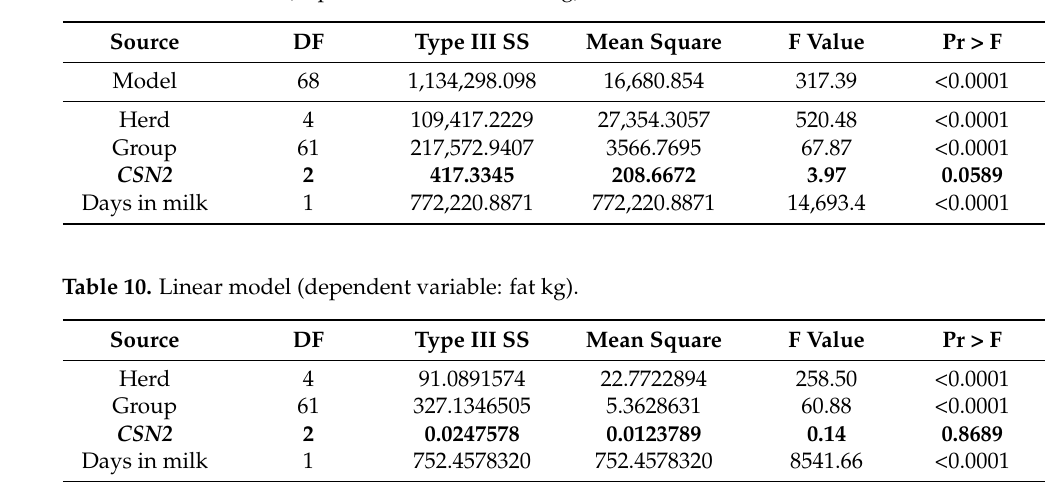
Table 9. Linear model (dependent variable: milk kg).